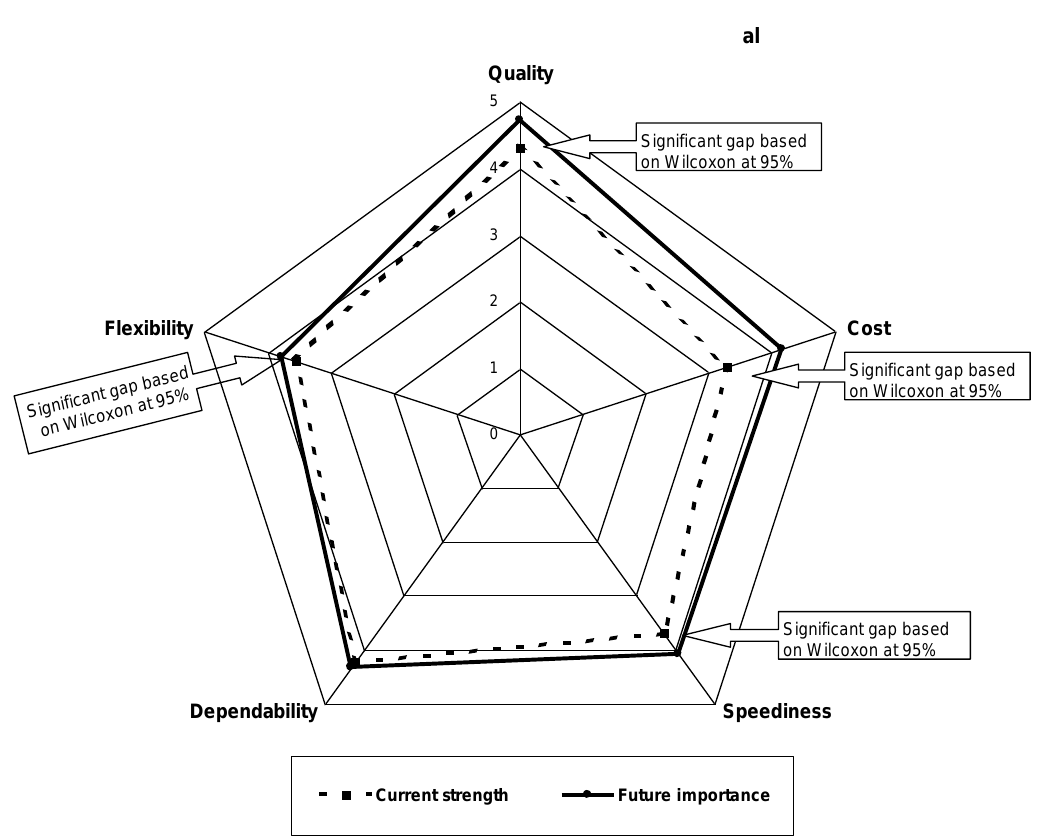
Graph 3: Current strength vs future importance